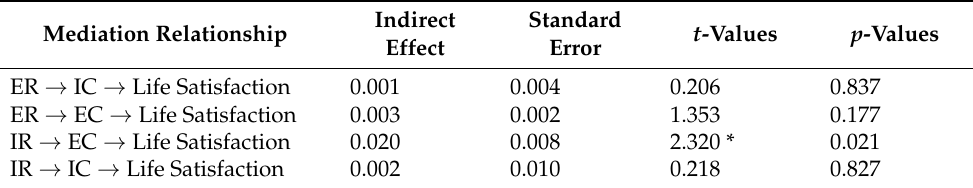
Table 5. Mediating effects of the model.